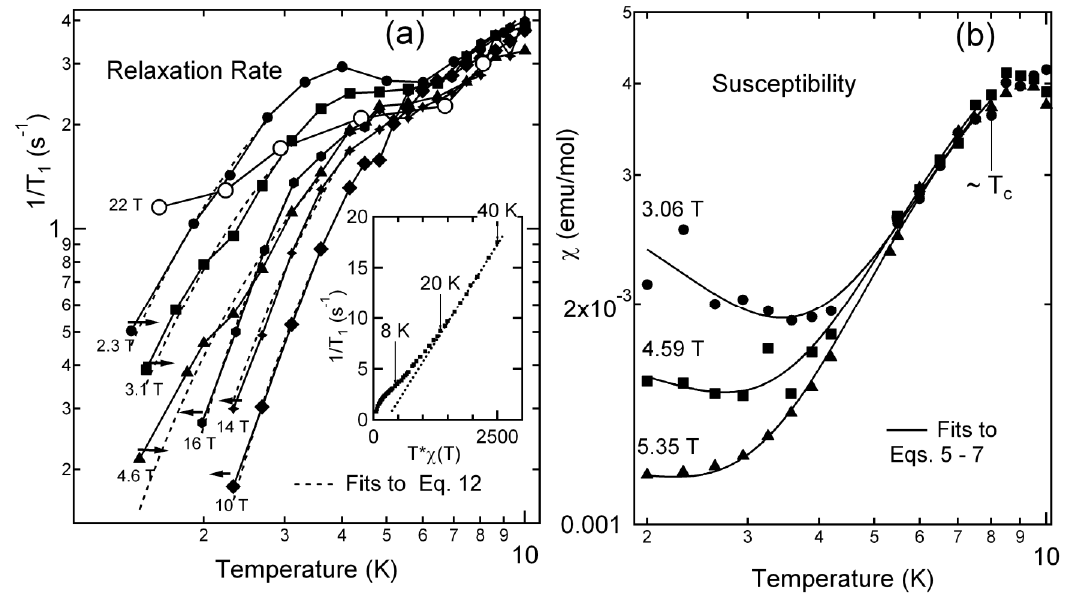
Figure 9. ( a ) Temperature dependence of 1/T fields. Arrows refer to direction of curves for increasing magnetic field. Inset: test of relationship 1/T ~ T* χ (T) showing deviation below 20 K (dashed line). Inset data is from 1 Reference [2]; ( b ) Susceptibility vs . temperature for selected magnetic